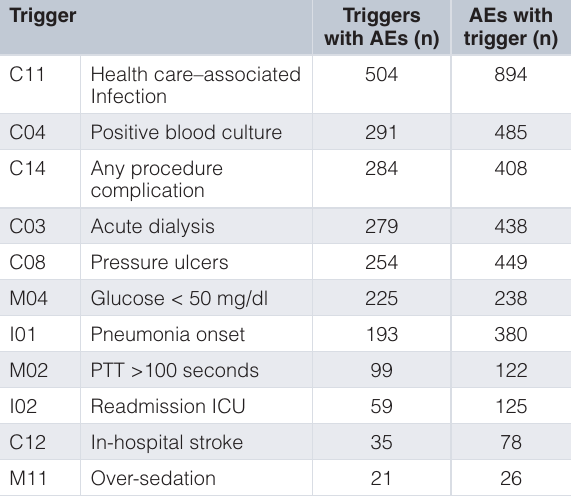
Table 3. Distribution of triggers and